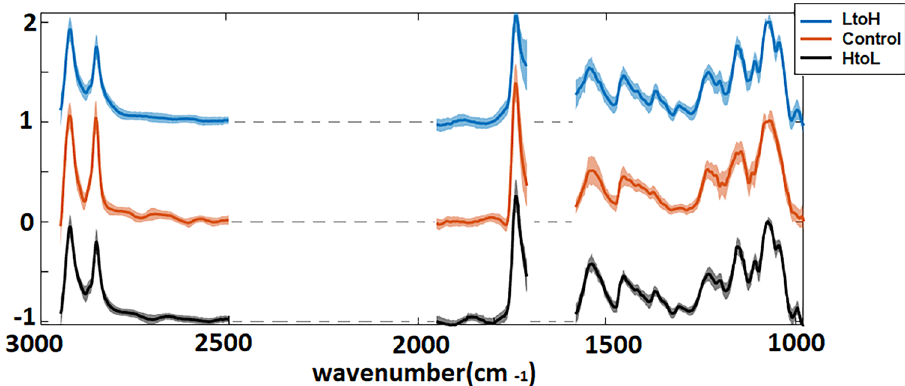
Figure 1. Average spectra of Thalassiosira weissflogii cells. The average spectra of a cell subject to a sudden change in CO 2 availability and of a control cell are shown. “LtoH” refers to a change from low (390 ppm) to high (5000 ppm) CO 2 concentration in the aqueous medium. “HtoL” refers to a high (5000 ppm) to low (390 ppm) CO 2 concentration transition. The shadows of each curve indicate the variance of the